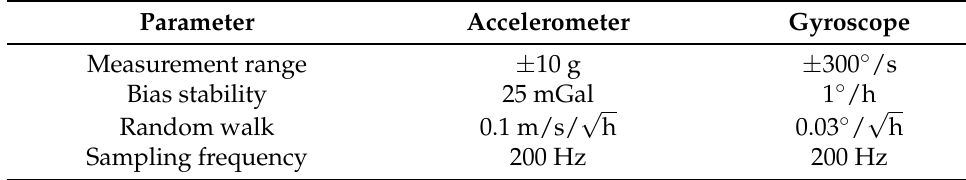
Table 3. Specifications of the IMU.